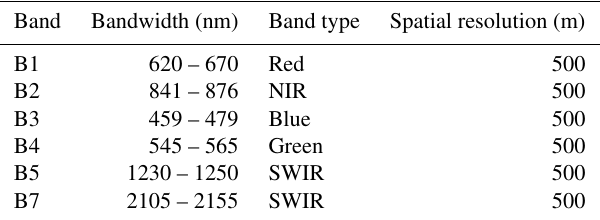
Figure 9. 3-D Model derived from the RPASs aerial photo and SfM elaborations photo overlap. The model shows the river embankment rupture, point B in Fig. 8a, and the geomorphological effects in the neighbour areas. It is also possible to estimate the water depth from the signs on the embankment. Table 4. Characteristics of the Aqua MODIS data used in this work.